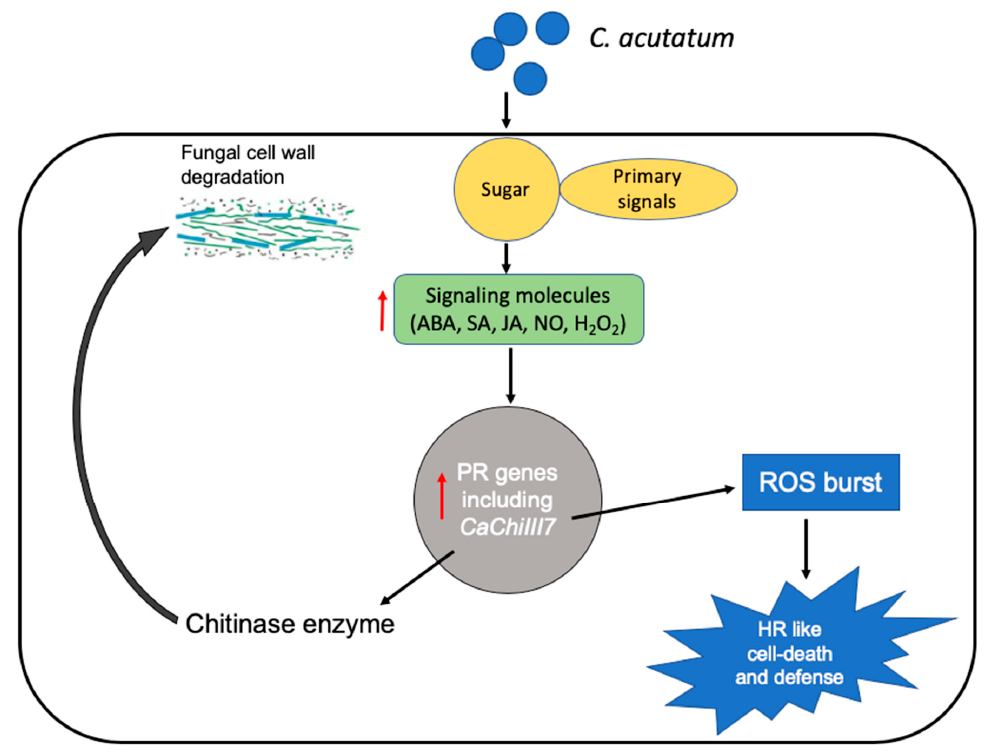
Figure 9. A model proposed for the chitinase gene CaChiIII7 during innate immunity against infection by Colletotrichum acutatum .